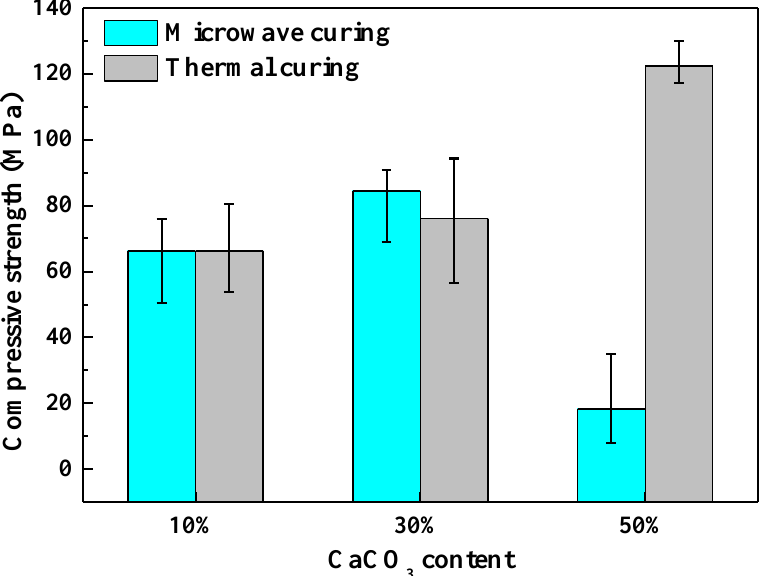
Figure 10. Compressive strength of the cured UPR composites under two curing methods.